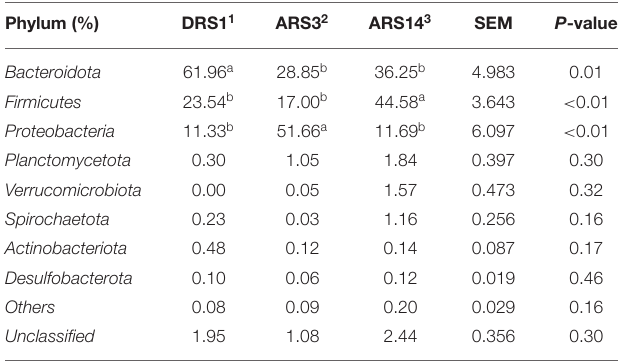
TABLE 5 | The composition of genus-level microbes in rumen fluid after fistula surgery in sheep and their relative abundance. Genus